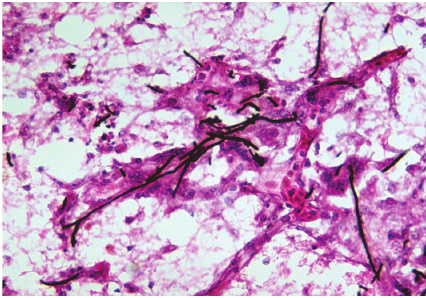
Figure 3: Microscopic image (Silver Methenamine, Haemotoxylin and Eosin Staining) of the 4th pedicle biopsy showing hyphae and yeast- like cells suggesting Pheohyphomycosis. The biopsy material was stained with Silver Methenamine with H&E counterstaining. Gram-positive hyphae/pseudohyphae can be